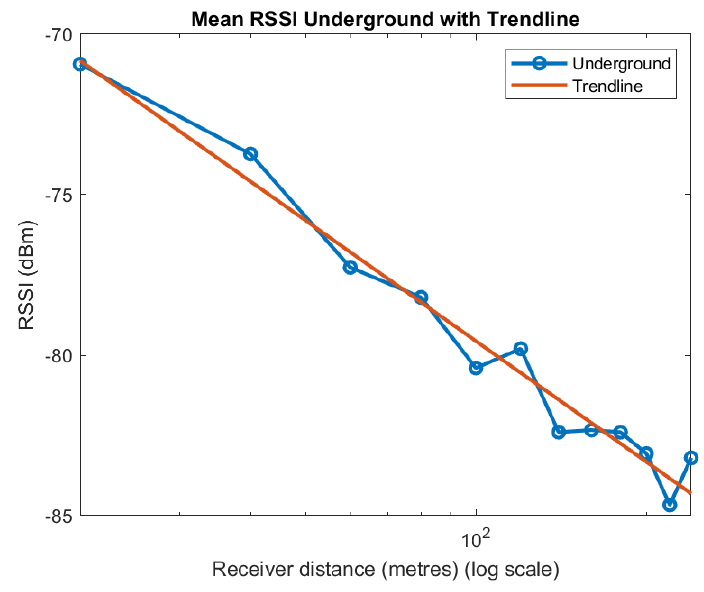
Figure 4. RSSI and trendline.